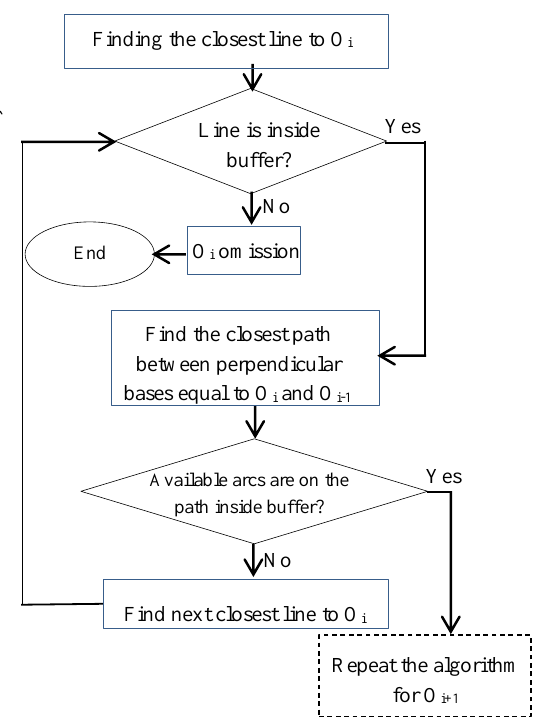
Figure 7. Algorithm for filtering of observed points and lines of the shortest path